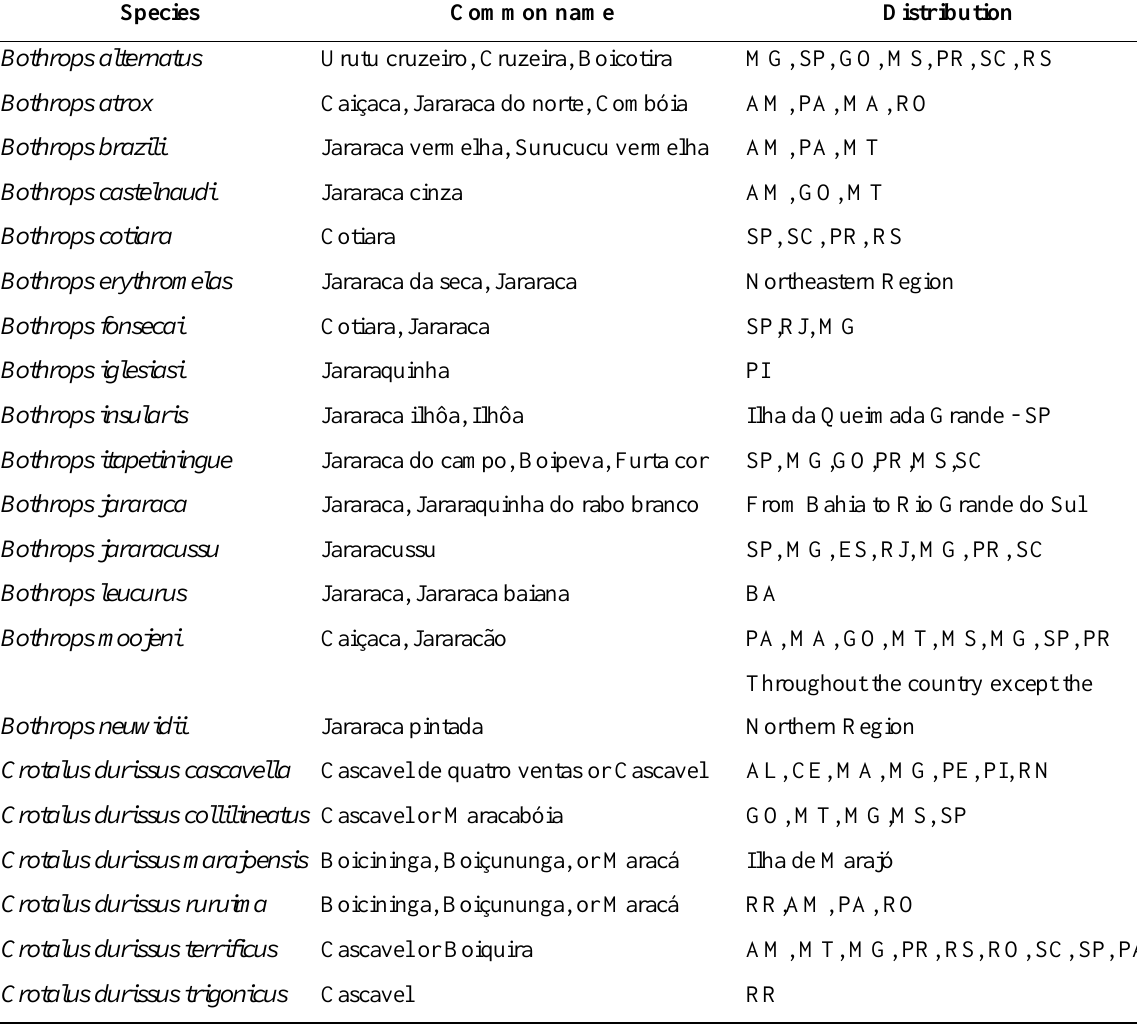
Table 1. Zoological classification, common names, and distribution of the main Bothrops and Crotalus snakes in